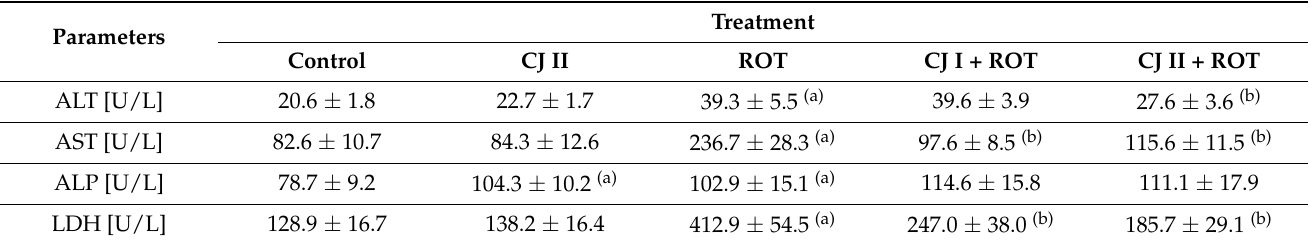
Table 3. Effect of cranberry juice (CJ) on liver function markers in rotenone (ROT)-injected rats. Parameters